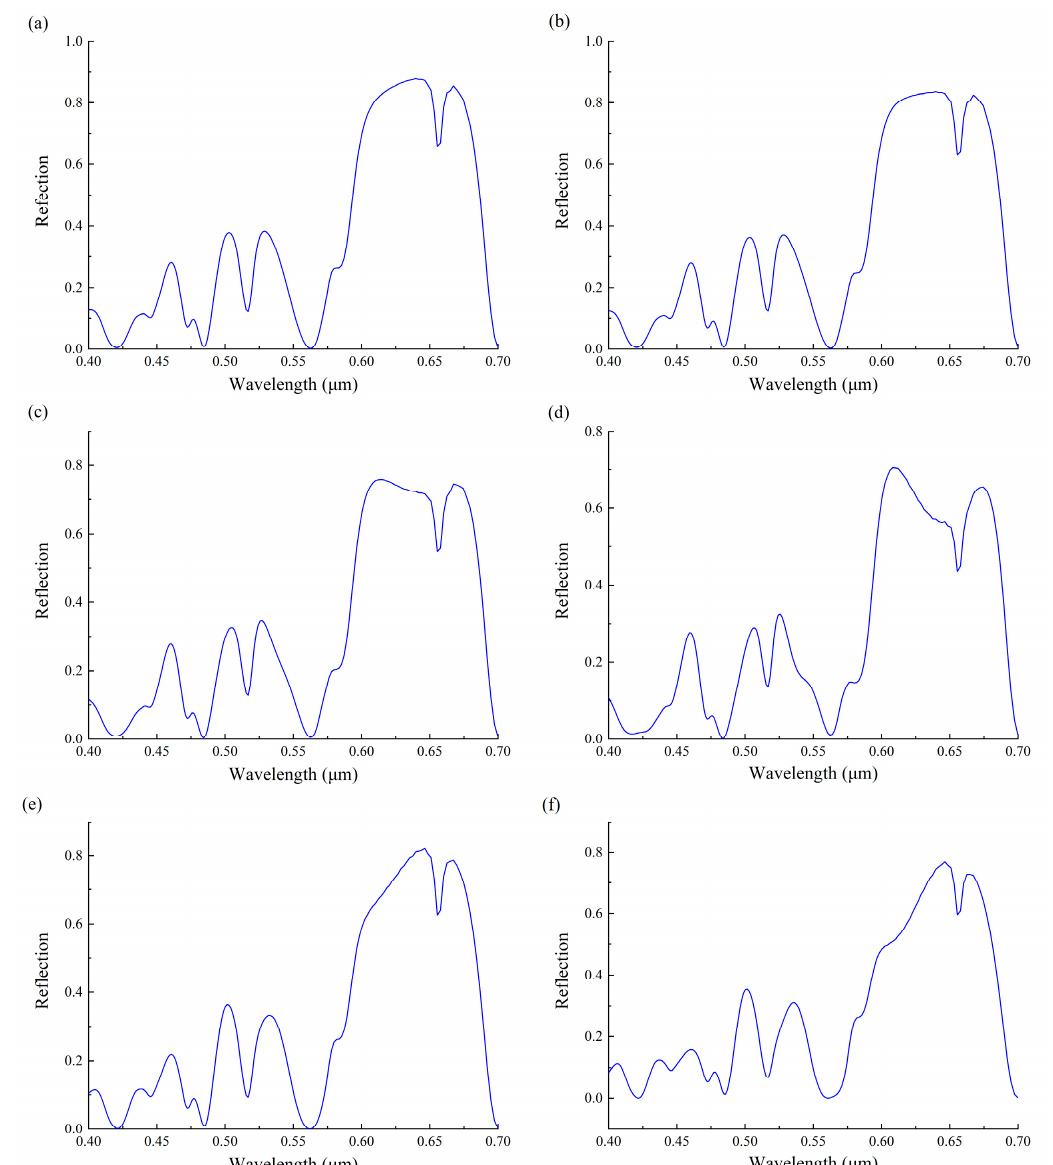
Figure 5. The reflection spectra as a result of changing the incident light’s tilt angle. ( a ) The reflection spectra with the tilt angle being 0°. The maximal reflectivity is 87.87%. ( b ) The reflection spectra with the tilt angle being 10°. The maximal reflectivity is 83.65%. ( c ) The reflection spectra with the tilt angle being 20°. The maximal reflectivity is 75.9%. ( d ) The reflection spectra with the tilt angle being 30°. The maximal reflectivity is 70.5%. ( e ) The reflection spectra with the tilt angle being 20° and the electric field direction rotated by 90°. The maximal reflectivity is 82.1%. ( f ) The reflection spectra with the tilt angle being 30° and the electric field direction rotated by 90°. The maximal reflectivity is 77%.